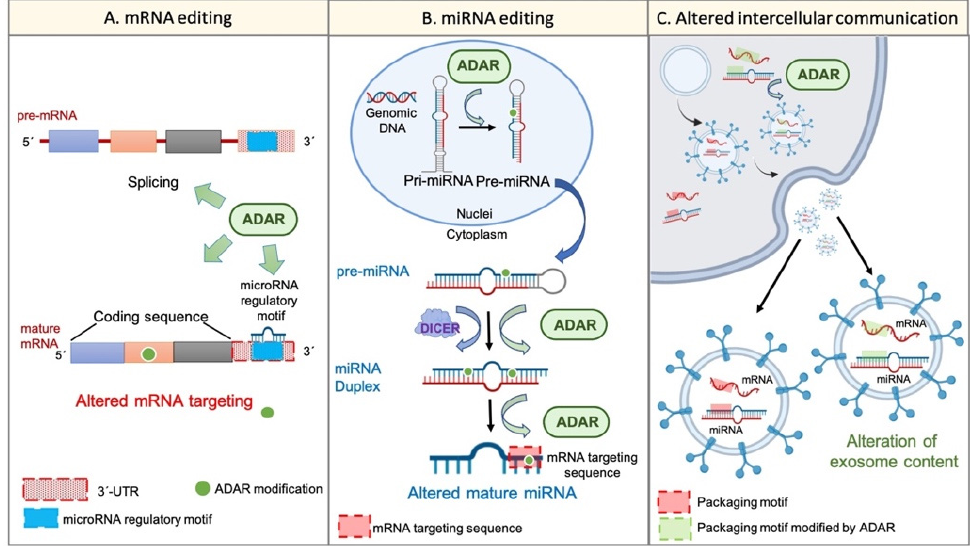
Figure 2. Wide transcriptome alteration by ADARs. Panel ( A ) shows the ADAR-mediated mRNA editing. ADARs can influence pre-mRNA maturation by interfering with the splicing process. Furthermore, ADARs can edit mature transcripts on different sites. For instance, ADARs can modify the “miRNA regulatory motif” within the 3 ′ UTR region and, thus, can alter mRNA regulation by certain miRNAs. On the other hand, ADARs are able to edit the coding sequence of the mature transcript, thereby conditioning the final protein. Panel ( B ) represents the miRNA alteration by RNA editing. ADARs can regulate the multistep biogenesis of miRNAs in different ways; for example, the direct precursor editing or the physical interaction with regulatory factors, such as Dicer. Additionally, ADARs may edit the mature miRNA within its “mRNA targeting sequence”, thereby altering its mRNA targeting potential. Panel ( C ) shows the potential regulation of intercellular communication and extracellular vesicle cargos by single-nucleotide editing. RNA editing by ADARs can modify specific sequences within cellular mRNAs and miRNAs, such as the “zip code-like sequence” or the “surface targeting motif”, respectively (“packaging motifs”). The editing of such motifs may condition the packaging of certain mRNAs and miRNAs into extracellular vesicles, such as exosomes, and may alter the intercellular communication and the coordinated behaviour of a cellular population.